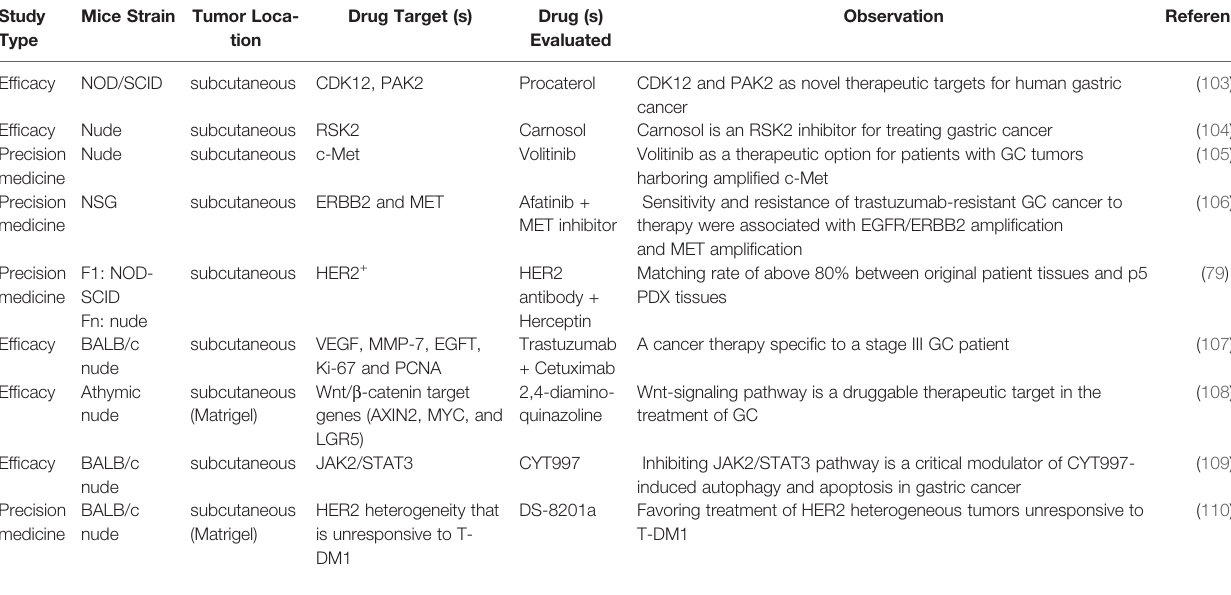
TABLE 2 | GCPDX models as preclinical research tools to evaluate drug ef fi cacy. Study